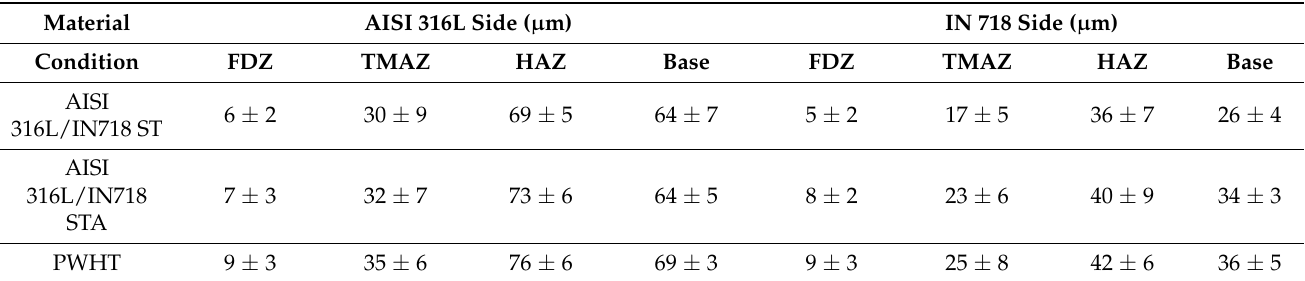
Table 4. The average grain sizes of dissimilar friction weldments AISI 316L/IN718 ST, AISI 316L/IN718 STA, and PWHT.